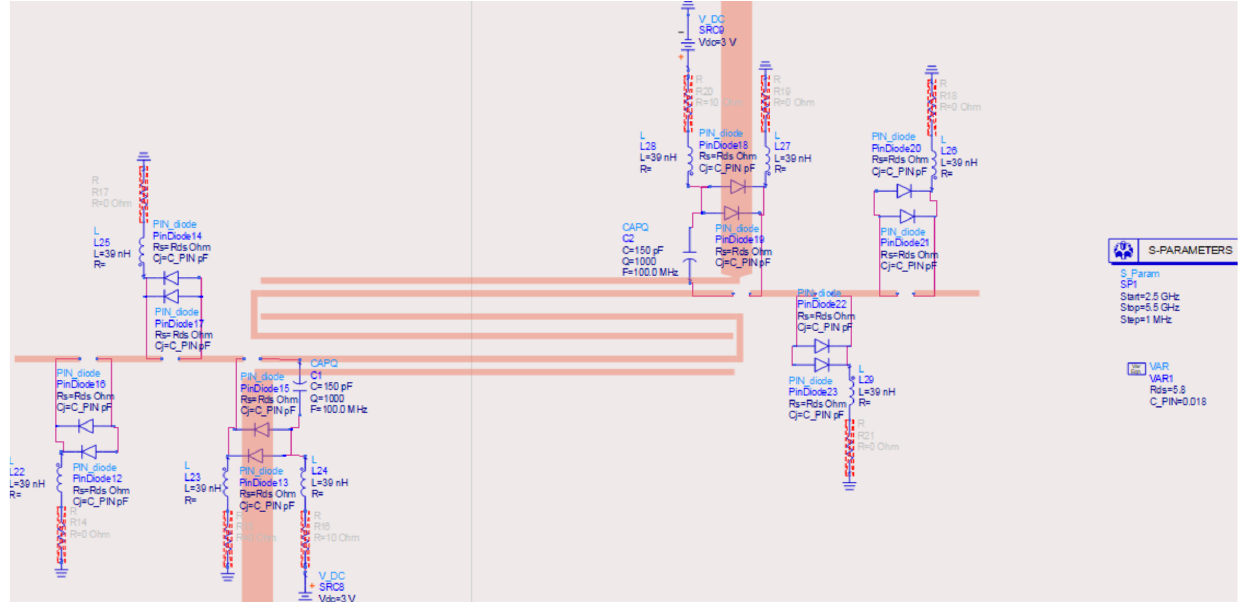
Figure 9. ADS schema of the reconfigurable interdigitated pseudohairpin filter based on PIN diodes. The simulated scattering parameters obtained for the four different PIN diode